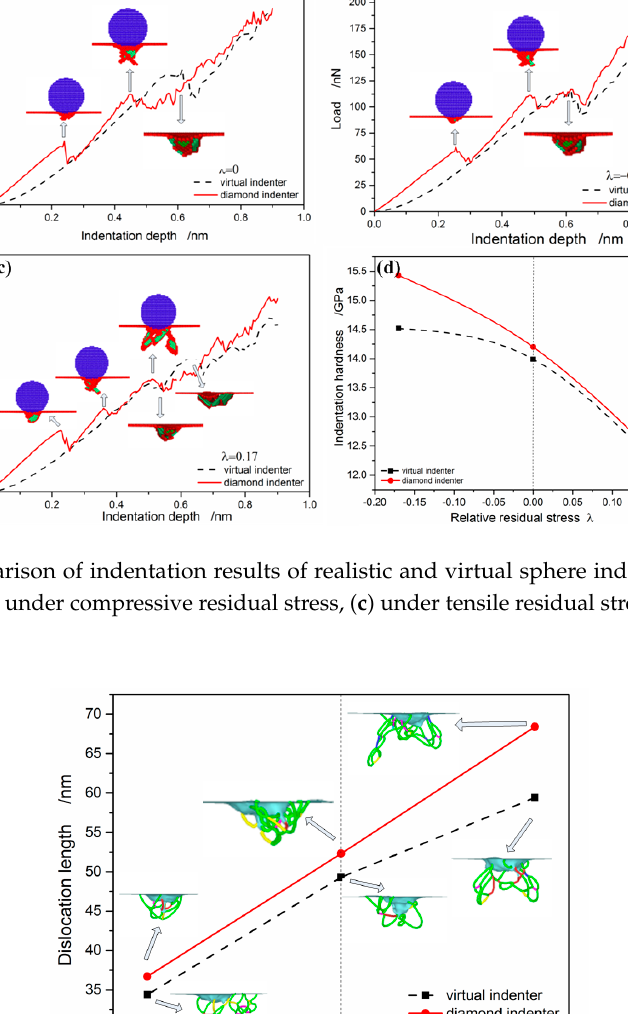
= ). = ). Figure 16. Dislocation length vs. relative residual stress under the same indentation depth ( h = 0.9